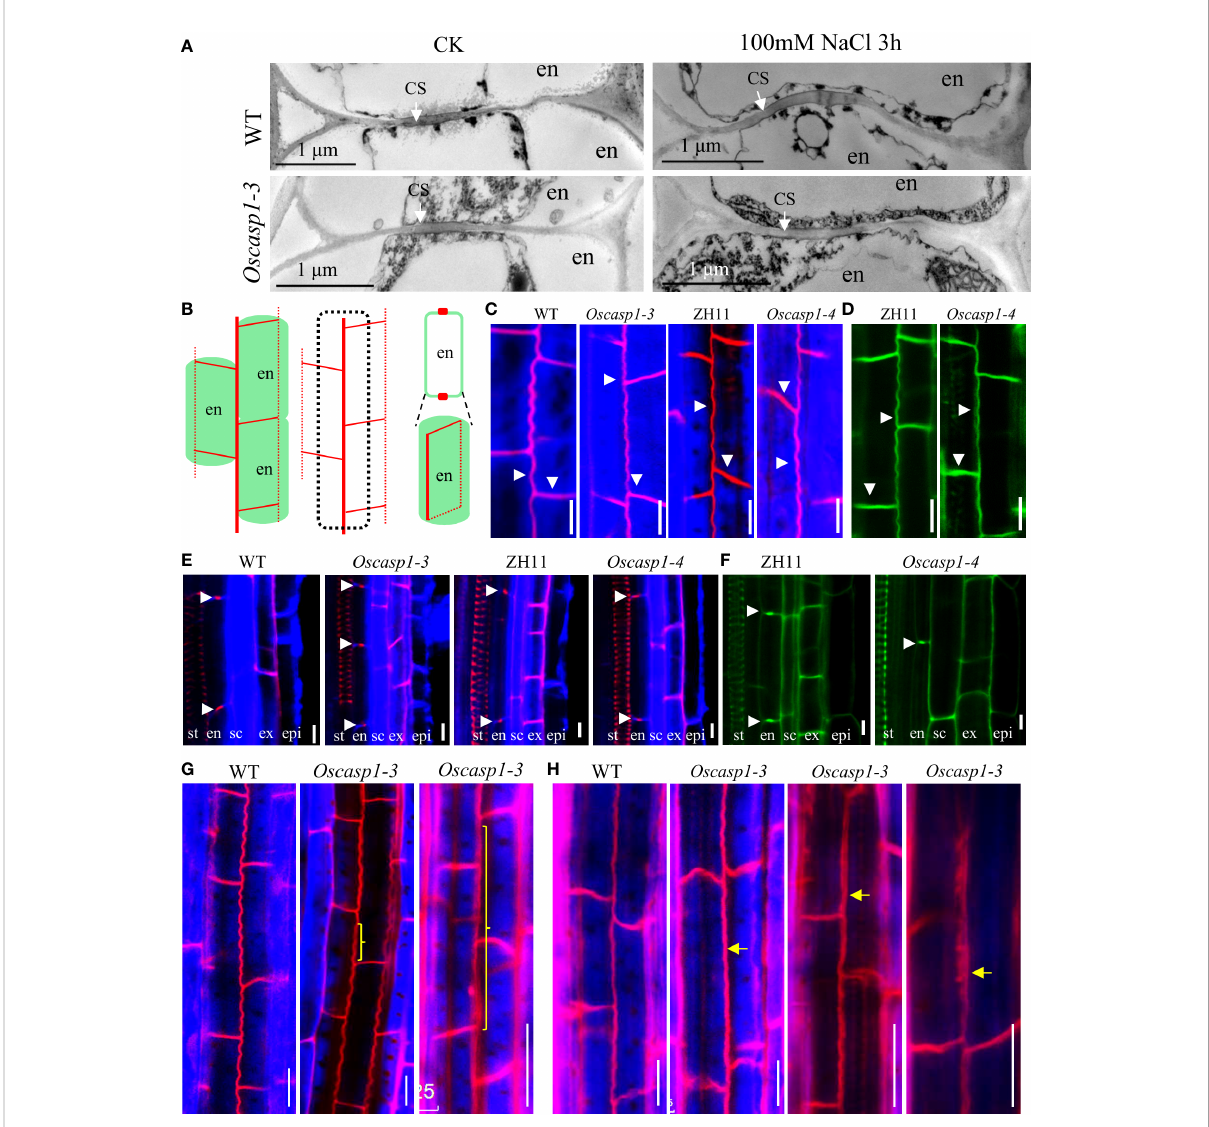
FIGURE 3 The Casparian strip structures of the roots. (A) The representative transmission electron micrographs of CS in primary roots of WT and Oscasp1- 3 , WT and Oscasp1-3 treated with salt stress. These transverse sections were at 10 mm from primary root tip. (B) Cartoons of the observed lines and dots in an optical section, which represent a longitudinal and horizontal band in three dimensions, respectively. (C, E , G, H) SLRs stained with Basic Fuchsin and Calco fl uor White in ClearSee solution. (D, F) SLRs stained with Auramine O in ClearSee solution. (C, D) The representative longitudinal and horizontal normal CS bands. (E, F) The representative CS dots. epi: epidermis; ex: exodermis; sc: sclerenchyma; en: endodermis. (G, H) The abnormal longitudinal CS bands in Oscasp1-3 . Yellow curly brackets and arrows indicate abnormal CSs. (G) SLRs of 5-d-old seedling. (C – F, H) SLRs of 10-d-old seedling. Scale bar = 10 m